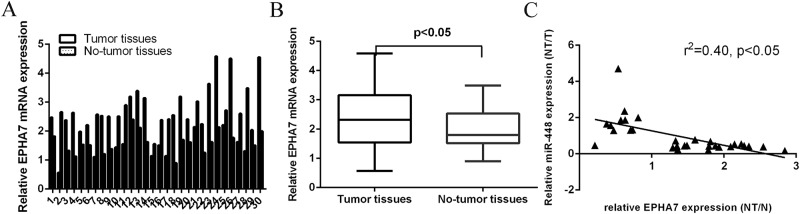
EPHA7 expression was upregulated in osteosarcoma tissues.(A) The expression level of EPHA7 in osteosarcoma tissues and their related normal tissues was measured by qRT-PCR. (B) The expression level of EPHA7 was higher in the osteosarcoma tissues compared to that in the related normal tissues. (C) The expression level of EPHA7 was inversely correlated with that of miR-448 in osteosarcoma tissues.